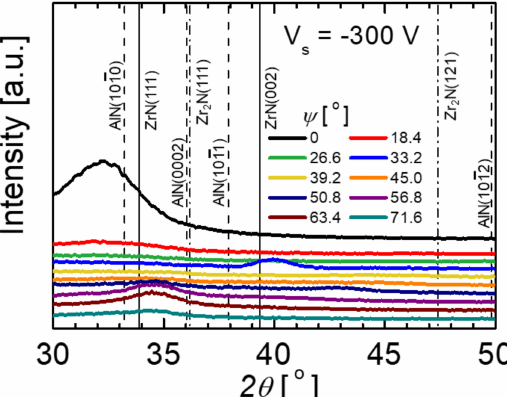
Figure 6. The set of XRD θ –2 θ scans recorded as a function of the tilt angle ψ from Zr 0.48 Al 0.52 N films grown with the synchronized substrate bias with the amplitude V s − 300 V and the HiPIMS current density intentionally reduced to 0.05 A · cm − 2 , which is characteristic of conventional